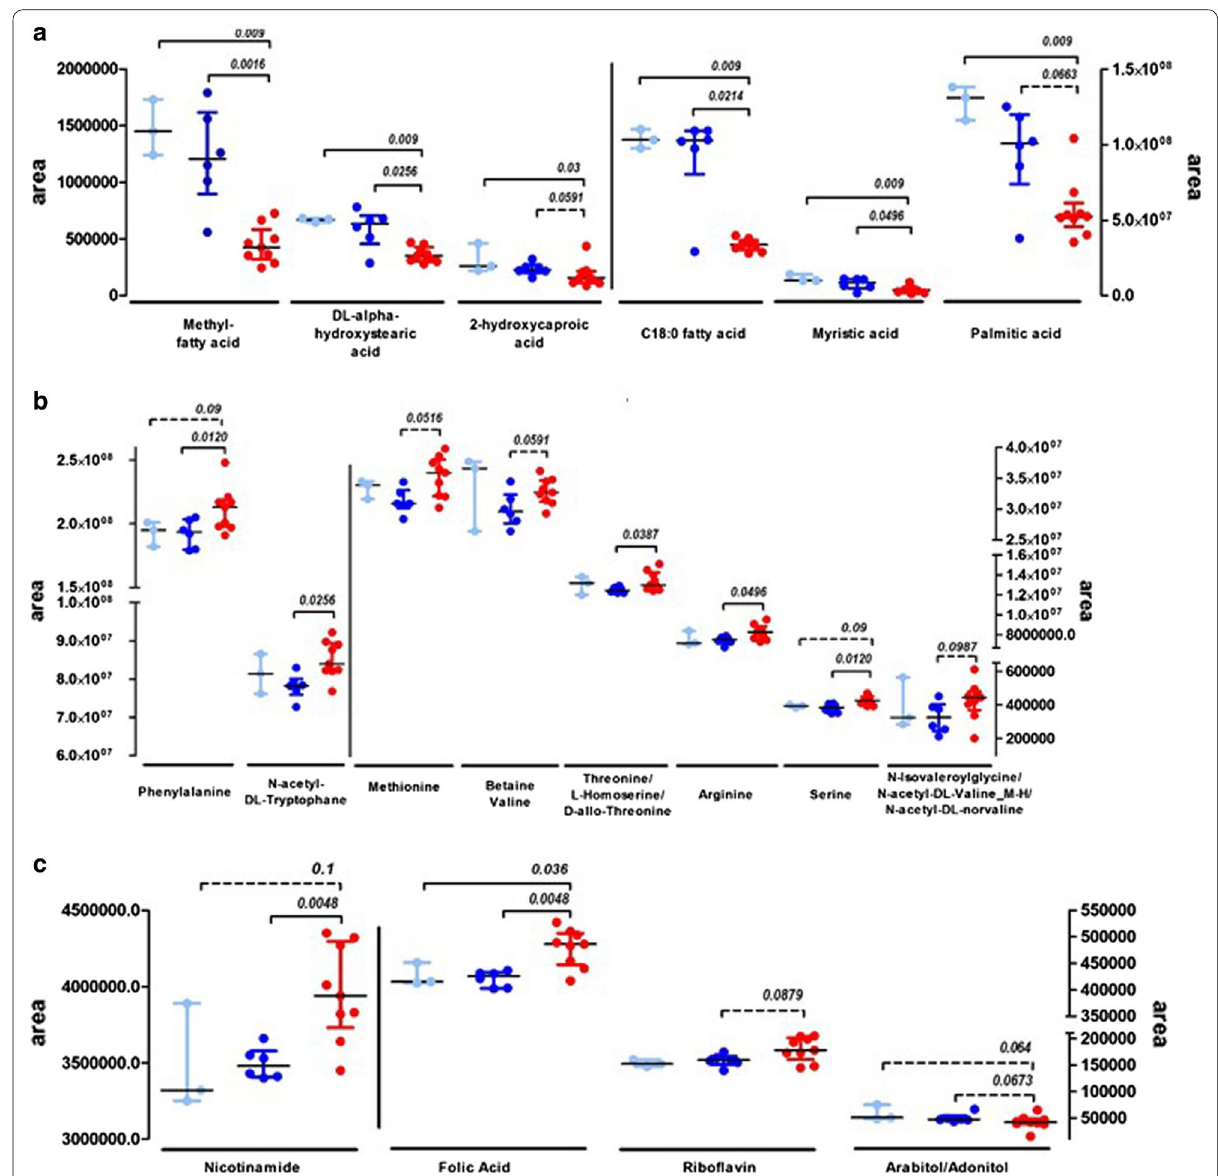
Fig. 8 Plasma metabolites in samples from CM‑FPIES, IgE‑CMA or resolved IgE‑CMA patients. a Discriminant metabolites between CM‑FPIES (red symbols), IgE‑CMA (dark blue symbols) and IgE‑resolved (light blue symbols). a Fatty acids, b amino acids and their derivatives, c purine metabolites or vitamins. The p values of nonparametric Mann–Whitney statistical test are